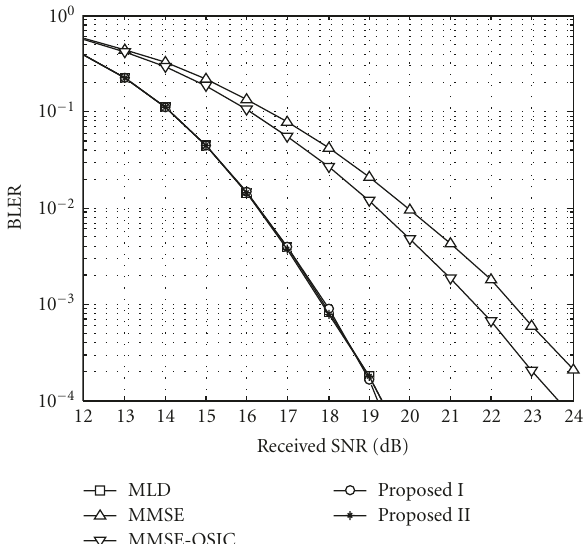
Figure 9: Comparison of the BLER performance of the first PSS for the proposed and the conventional schemes when both MSs transmit with (16QAM, 3/4).